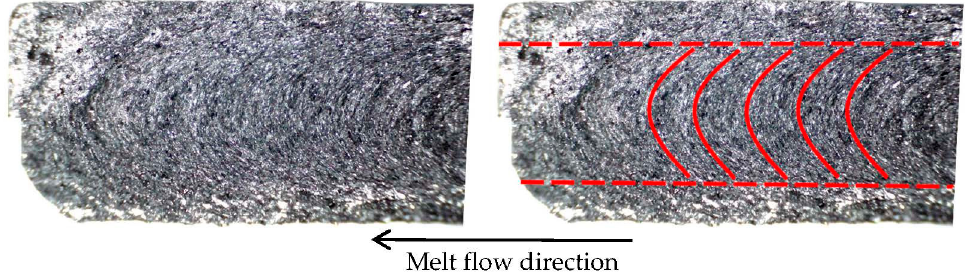
Figure 7. Internal structure along the height of a fractured fin of the heat sink prototype ( left ) with highlighted flakes’ orientation ( right ).